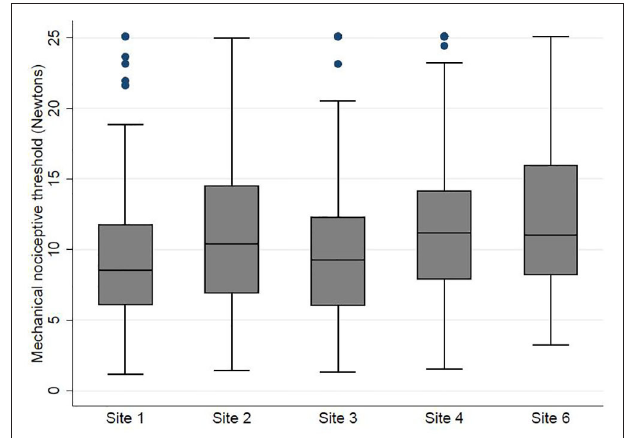
FIGURE 3 | A Tukey boxplot displaying mechanical nociceptive threshold at five sites of the thorax of 35 calves measured by pressure algometry.